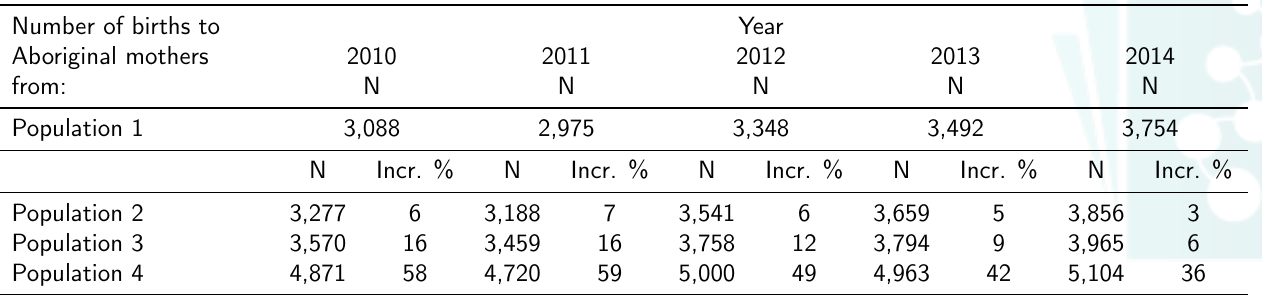
Table 1: Number (N) of births to Aboriginal mothers in 2010 to 2014 (including multiple births and births to interstate residents) according to the four study populations and the percent increase from study population